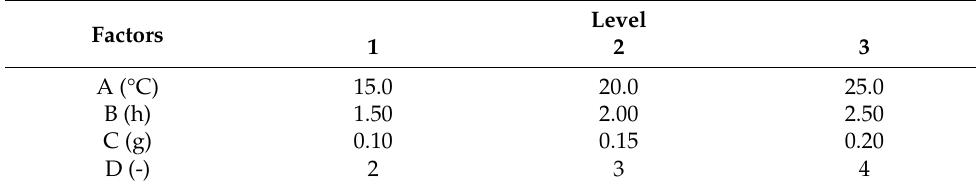
Table 1. Factors and levels for the experimental design.